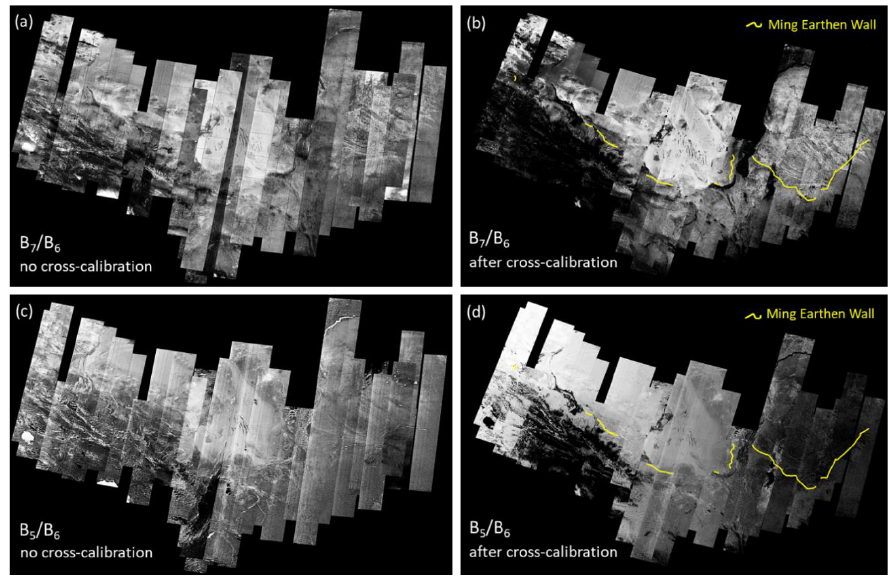
Figure A1. ( a ) ASTER B 7 / B 6 mosaic generated from L1T data, i.e., no image cross-calibration applied; ( b ) ASTER B 7 / B 6 mosaic after image cross-calibration (and transformation from universal transverse Mercator (UTM) to geographic latitude-longitude); ( c ) ASTER B 5 / B 6 mosaic generated from L1T data, i.e., no image cross-calibration applied; and ( d ) ASTER B 5 / B 6 mosaic after image cross-calibration (and geometric transformation from UTM to geographic